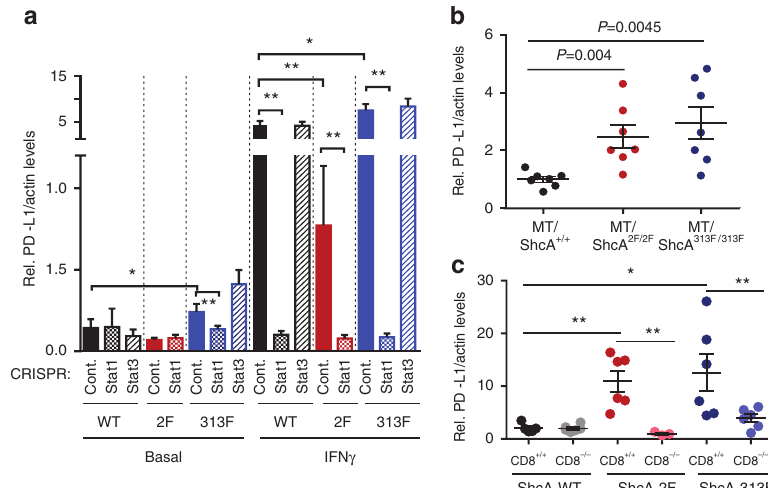
Figure 5 | Loss of phospho-Y239/240-ShcA signalling increases PD-L1 expression on mammary tumours. ( a ) Relative PD-L1 mRNA levels normalized to Actb levels were determined by RT–quantitative PCR in control, STAT1 -null or STAT3 -null cells of the indicated genotypes: MT/ShcA þ / þ (864), MT/Shc 2F/2F (5372), MT/Shc 313F/313F (6738)) that were cultured in the absence (PBS) or presence (0.2ngml (cid:2) 1 ) of IFN g for 24h. Data represented as mean ± s.d. ( b ) Relative PD-L1 mRNA levels (normalized to Actb ) in mammary tumours derived from MT/ShcA þ / þ , MT/Shc 2F/2F and MT/Shc 313F/313F transgenic mice ( n ¼ 7 tumours per genotype) ± s.e.m. ( c ) Relative PD-L1 mRNA levels (normalized to Actb ) in mammary tumours from CD8 þ / þ and CD8 (cid:2) / (cid:2) mice injected with breast cancer cells of the indicated genotypes: MT/ShcA þ / þ (864), MT/Shc 2F/2F (5372) and MT/Shc 313F/313F (6738). Data represented as mean ± s.e.m. ( n ¼ 6 tumours each) (* P o 0.05 and ** P o 0.01; unpaired two-tailed Student’s t -test for a and Wilcoxon’s rank-sum test for b , c